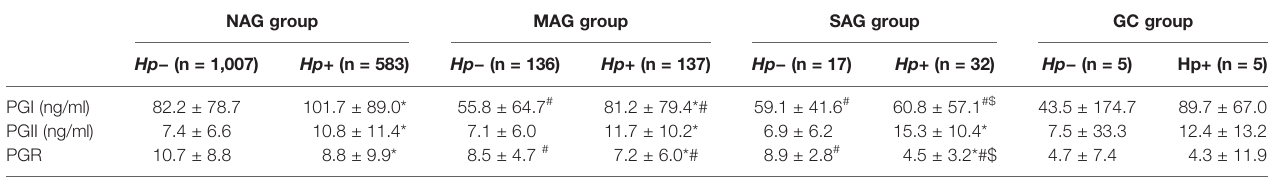
TABLE 2 | Differences in serum PG levels among the NAG, MAG, SAG, and GC group in subgroup analysis based on Hp infection.